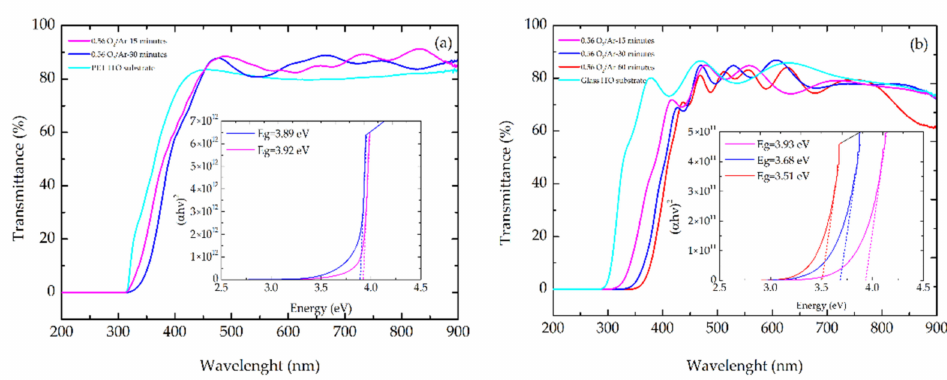
Figure 9. Transmission spectra and plots of ( α h ν ) 2 versus h ν for direct transition in MoO x films ( a ) grown on PET-ITO substrate and ( b ) grown on glass-ITO substrate at 0.56 O 2 /Ar flow rate ratio at different deposition